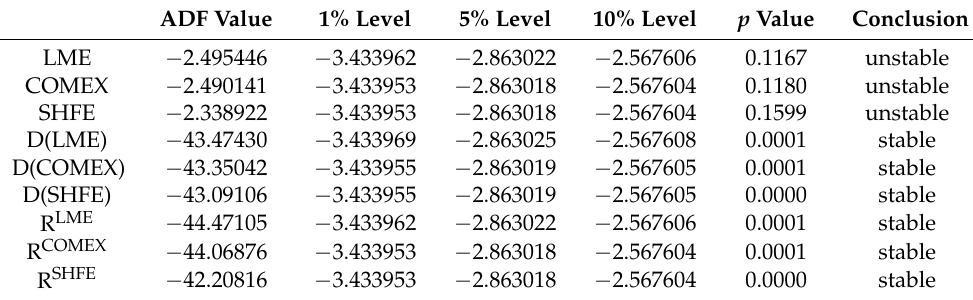
Table 2. Stationarity test of unit root ADF before the end of the stock market crash after the financial crisis.